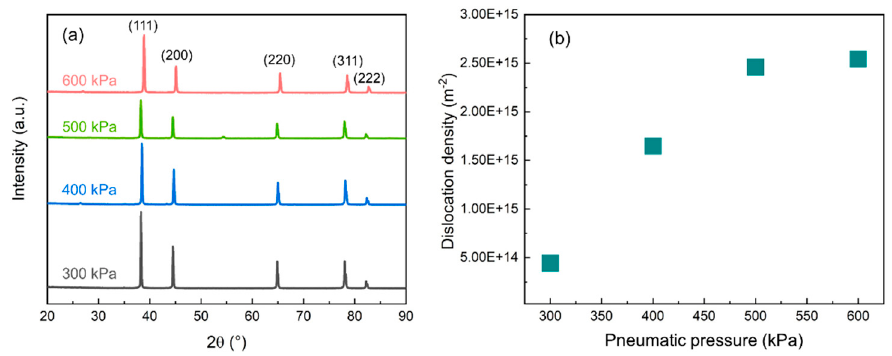
Figure 5. ( a ) XRD patterns of the sintered aluminum specimens. ( b ) Dislocation density of sintered specimens extracted from the XRD diffraction peaks.